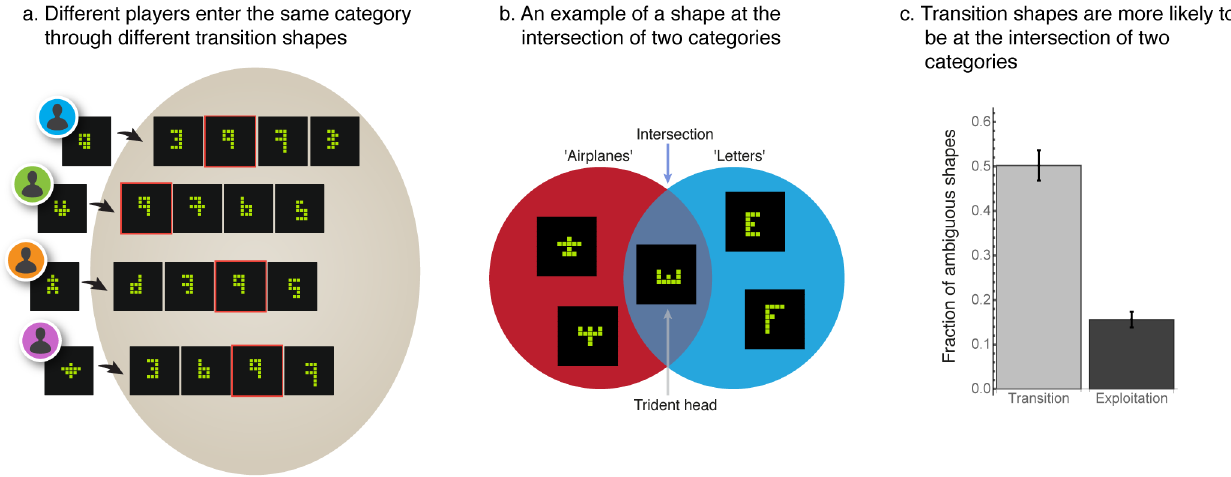
Fig 7. Discovery of a new exploitation phase occurs at a transition shape that is ambiguous in the sense that it belongs to multiple categories. A) Examplesof transition shapes at the entry to the category of ‘digits’ by four different players. Transition shapes are non- prototypical, for examplea ‘four that is not a four’, whereasshapes found after the transition shapetend to be more prototypical digits. B) A shape is ambiguousif it lies in the intersection of two or more categories (signifyingat least two contexts of meaning),as exemplified by the trident shapeshared by the categoriesof ‘airplanes’and ‘Englishletters’. C) Transition shapes are more likely to be ambiguous shapes than non- transition gallery shapes (transition shapes: Median= 50%, 95% CI = [49, 50]; non-transition shapes: Median= 15, 95% CI =